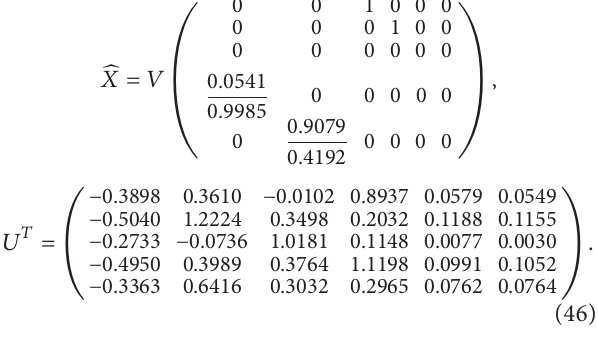
Figure 1(b) is the noisy image {𝑥 𝑝 }